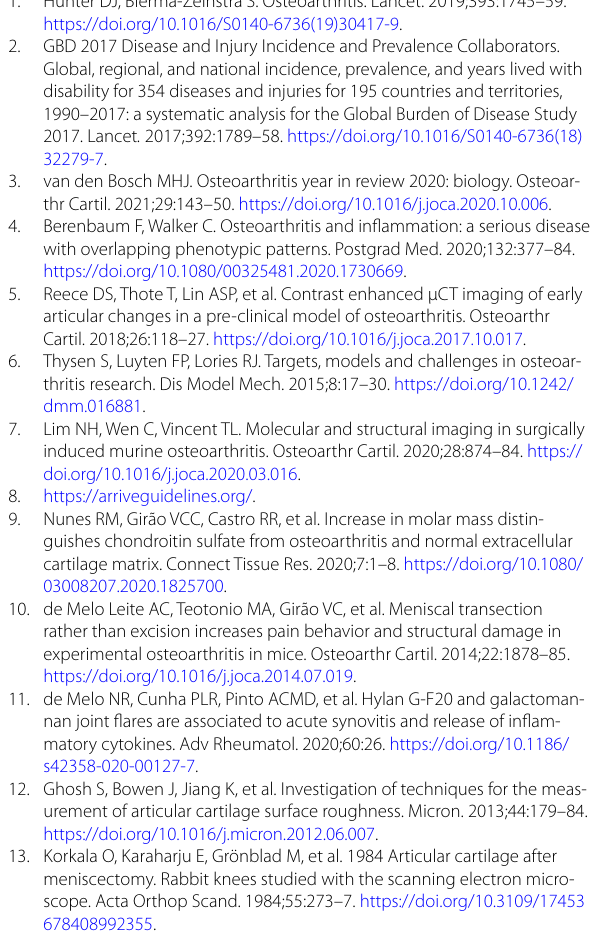
Three groups of mice were subjected to a sham procedure, transection of both the knee collateral and anterior cruciate ligaments (ACLT) or ACLT followed by transection of the medial meniscus (MNCT) and sacrificed at various days postsurgery. Cartilage damage in the distal femur and tibial plateau was evaluated using SEM, according to previous criteria (see text for details). Data represent medians (range) of n Wallys test